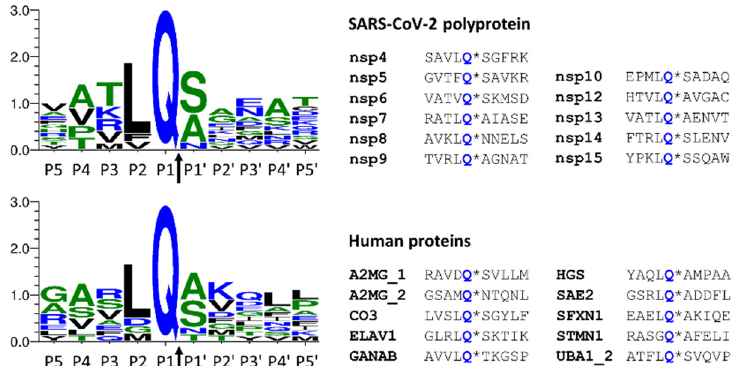
Figure 6. Comparison of cleavage site sequences. Autoproteolytic cleavage sites of SARS-CoV-2 pol- yprotein are shown, and the cleavage sites of Mpro identified in this work are also represented. The cleavage site sequences (P5-P5 ′ residues) of the viral polyprotein are shown based on Miczi et al. [12], and the sequences of human proteins are based on this study. The sequence logos were pre- pared using Weblogo 3.7.11 web server [31]. The arrows indicate the cleavage position between the P1 and P1 ′ residues.